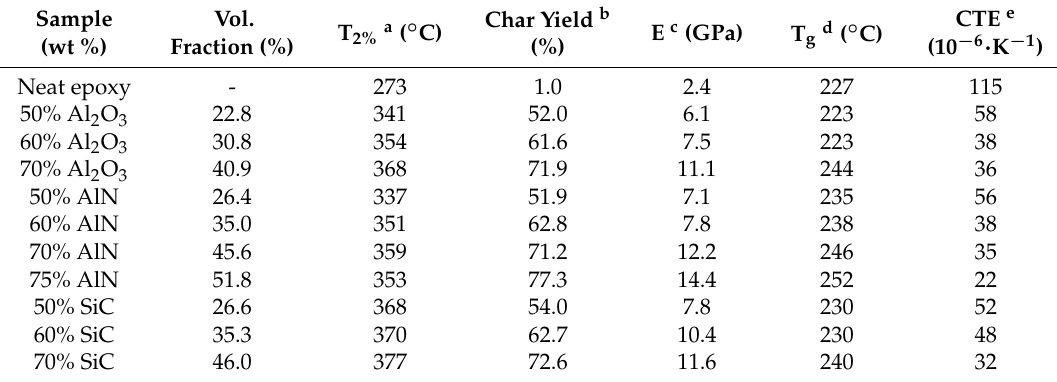
Table 2. Thermogravimetric and thermomechanical data from the composites prepared.